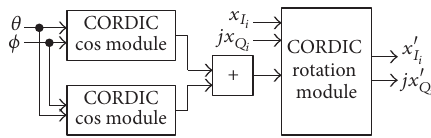
Figure 3: Single complex weighting module.